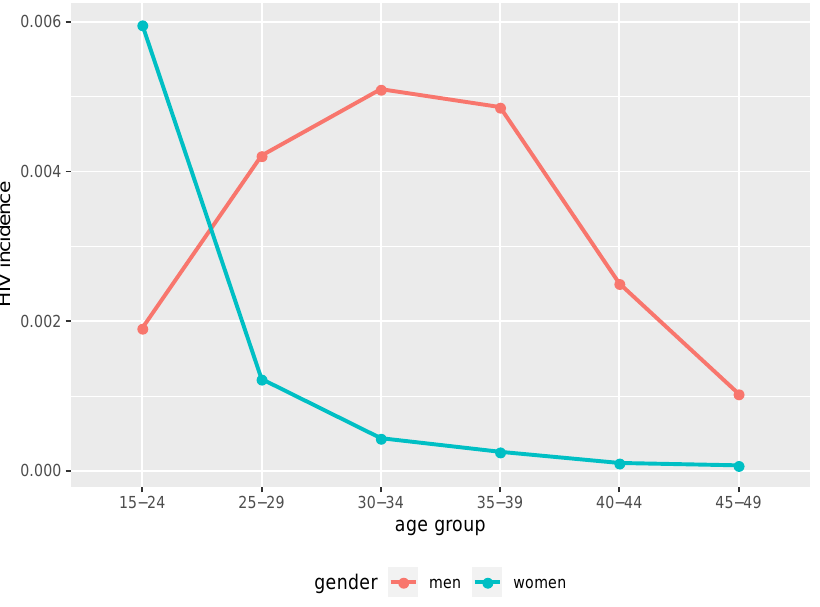
Figure 2. HIV incidence in 35–40 simulation time from the simulated epidemic. Age and gender structured incidence at 40 years of simulation time from benchmark data (2017 in calendar